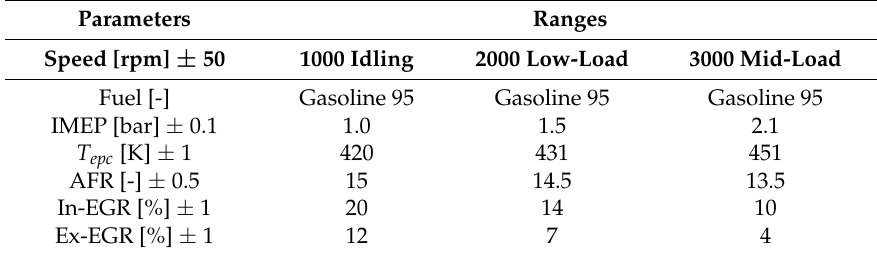
Table 2. Operating conditions of the engine for misfiring